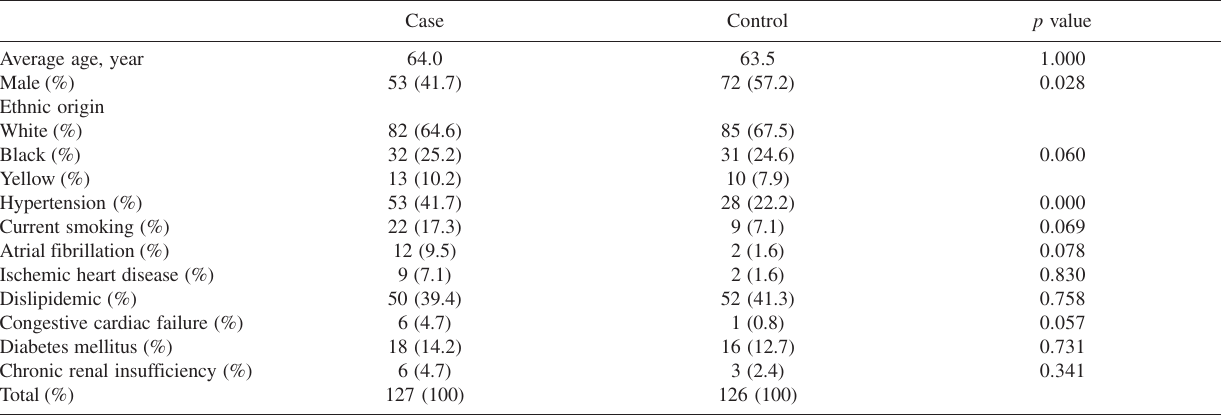
Table 1 - Clinical and demographic characteristics of ischemic stroke patients and control subjects studied